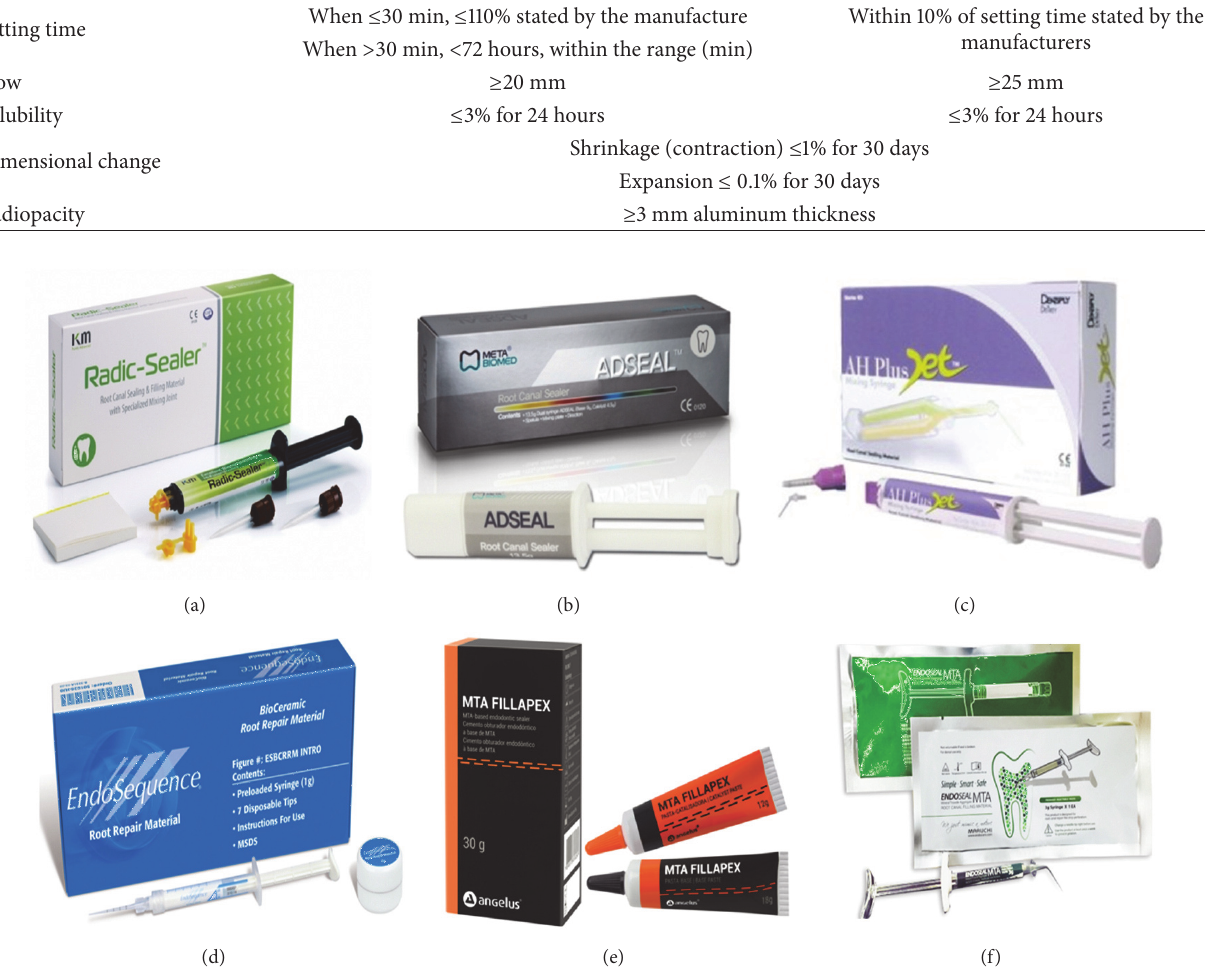
Figure 1: Six root canal sealers tested in the present study: (a) Radic-Sealer, (b) AD Seal, (c) AH-Plus, (d) EndoSequence BC Sealer, (e) MTA Fillapex, and (f) EndoSeal